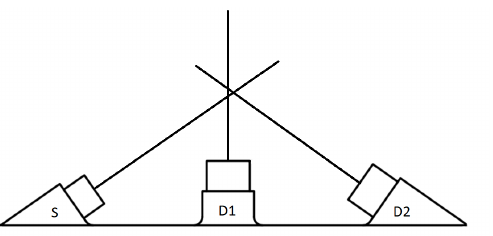
Figure 4. Schema of the dust sensor. S refers to the source. D1 and D2 refer to the backward and forward detectors,